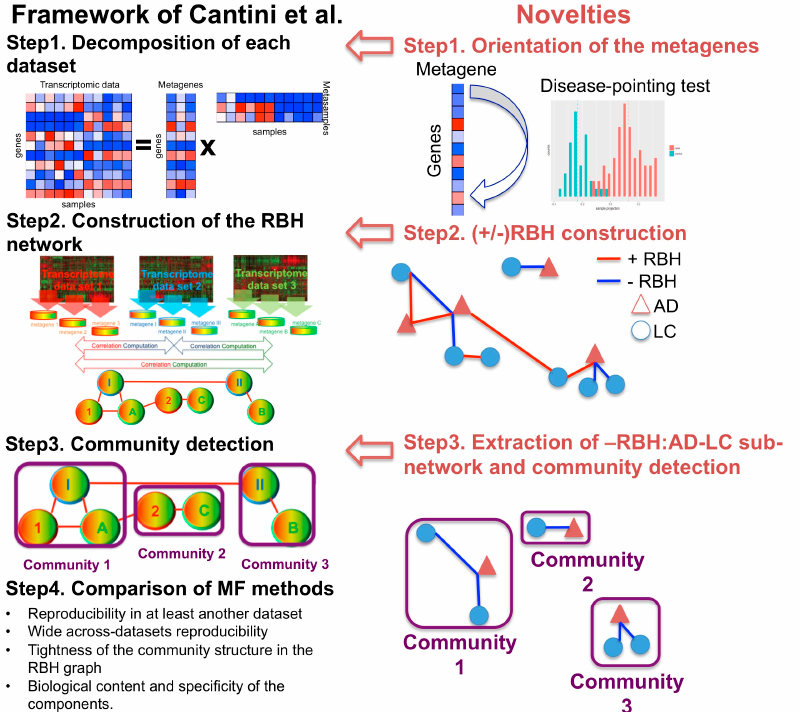
Figure 1. Schematic view of the framework and the novelties introduced with respect to [12]. RBH = reciprocal best hit. MF = matrix factorization. AD = Alzheimer’s disease. LC = lung cancer.